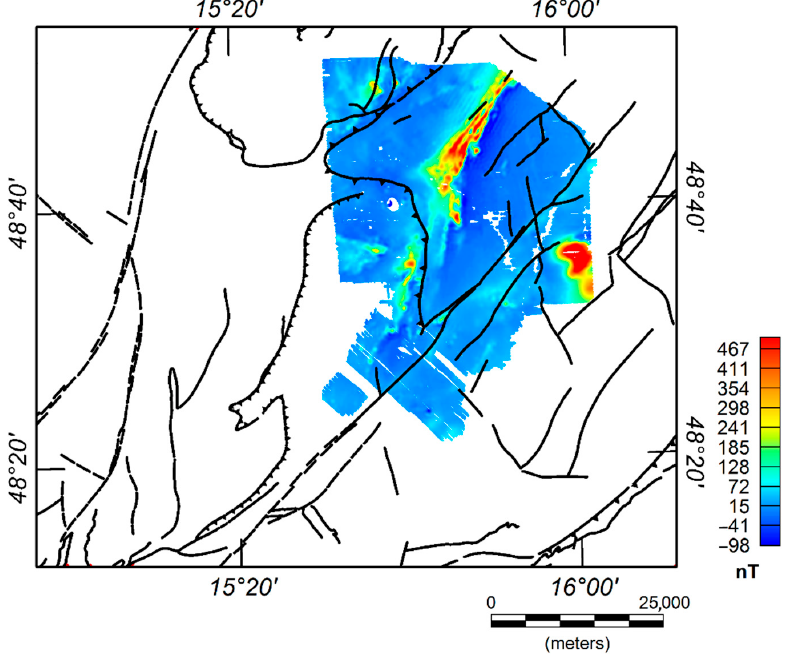
Figure 4. RTP Aeromagnetic map of the study area. Two main anomalies, with amplitude of about 500 nT, are located in the northern and eastern sides of the